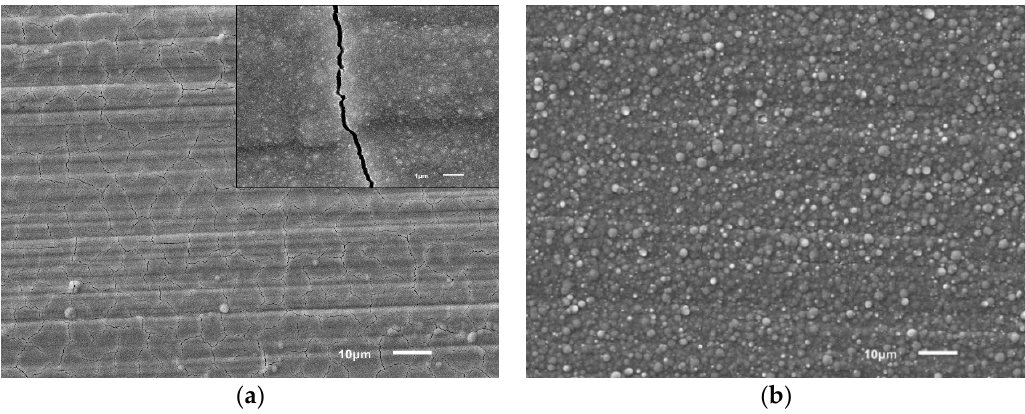
Figure 4. SEM images of Ni–W coatings of 5 μ m in thickness made using the PC mode in electrolytes with different pH: ( a ) 8.7, ( b ) 9.5. The inset box in the upper right corner of panel ( a ) shows an enlarged microcrack.